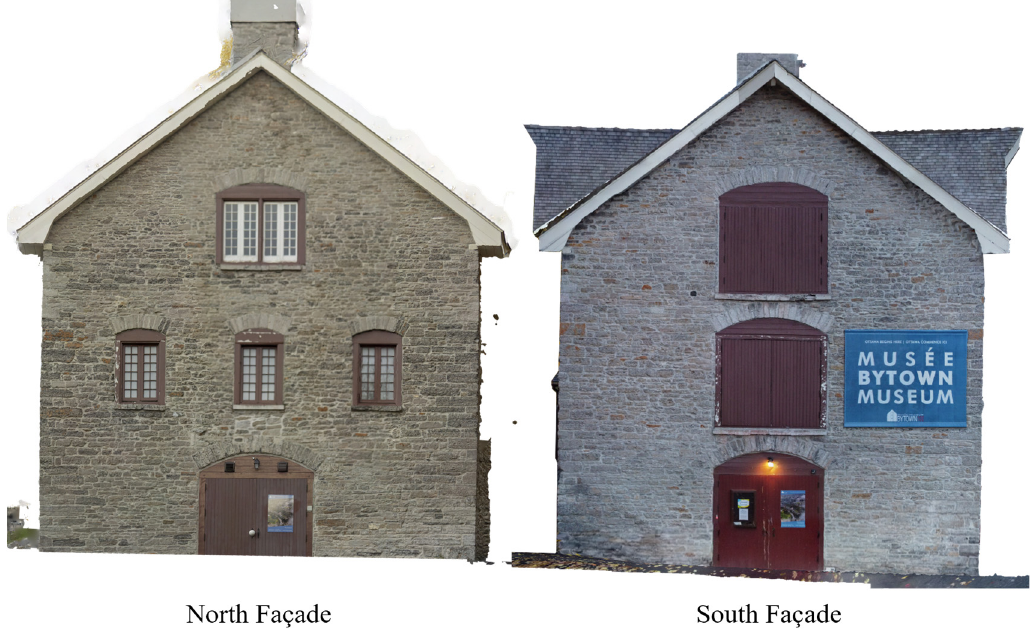
Figure 6. Orthometric images of the Bytown Museum.